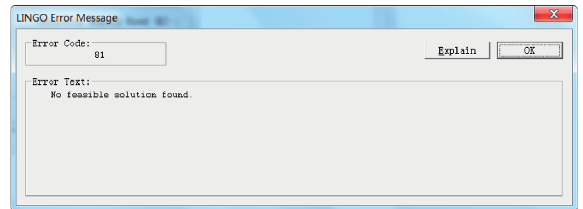
Figure 3: The execution result of the traditional